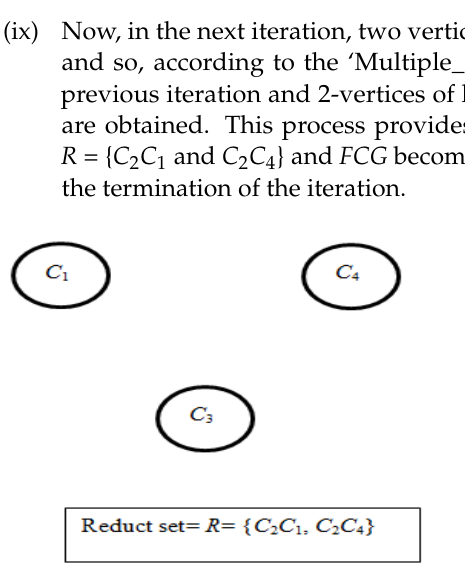
Figure 4. Modified FCG after first iteration.